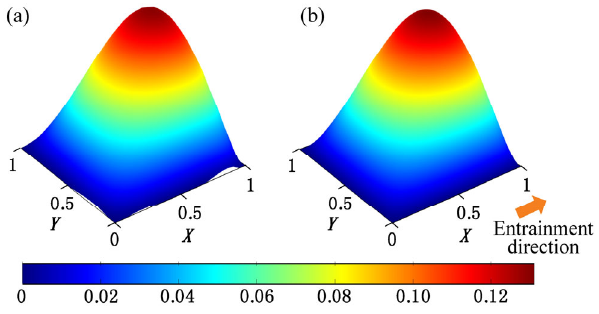
Fig. 14 Calculated pressure distributions ( U = 27 mm/s). (a) PINN. (b)